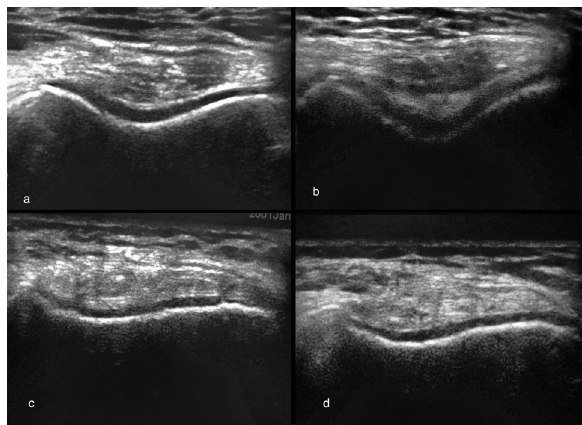
Figure 1. Ultrasound evaluation of femoral cartilage in four different patients, show various grades of femoral cartilage involvement in os-